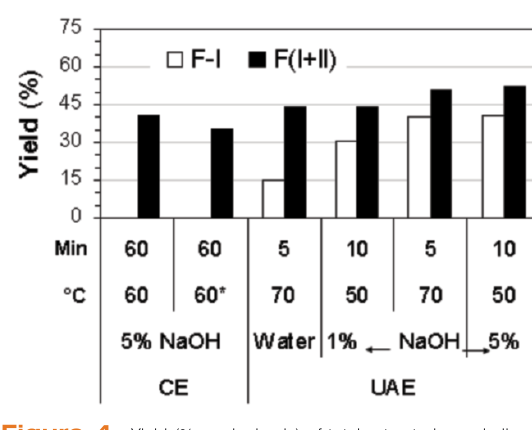
Figure 4. Yield (% on dry basis) of total extracted corn hull xylan F(I+II) and fraction (F-I) from step I obtained by classical (CE) and ultrasound-assisted extractions * Added 2% H O . 2 2